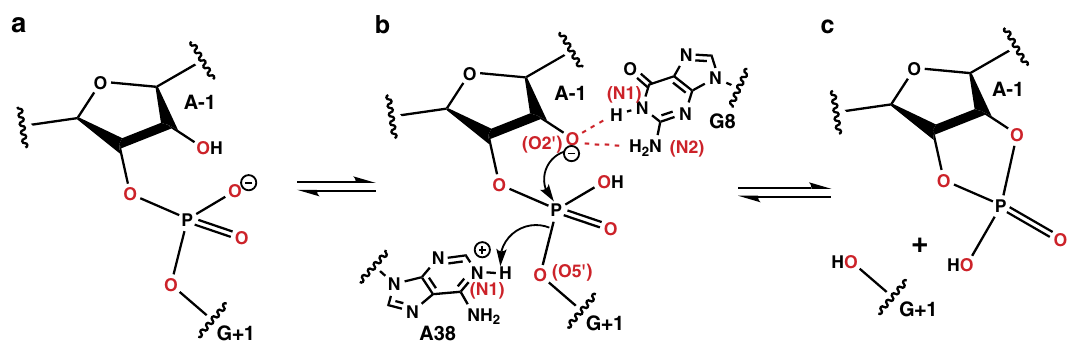
Figure 2 | Reaction scheme for the self-cleavage reaction step of the hairpin ribozyme. The activated precursor (AP) state of the ribozyme corresponds to ( b ), where the interacting nucleobases G8 and A38 are also shown. Panels ( a ) and ( c ) correspond to the pre-catalytic state and the products formed, respectively.